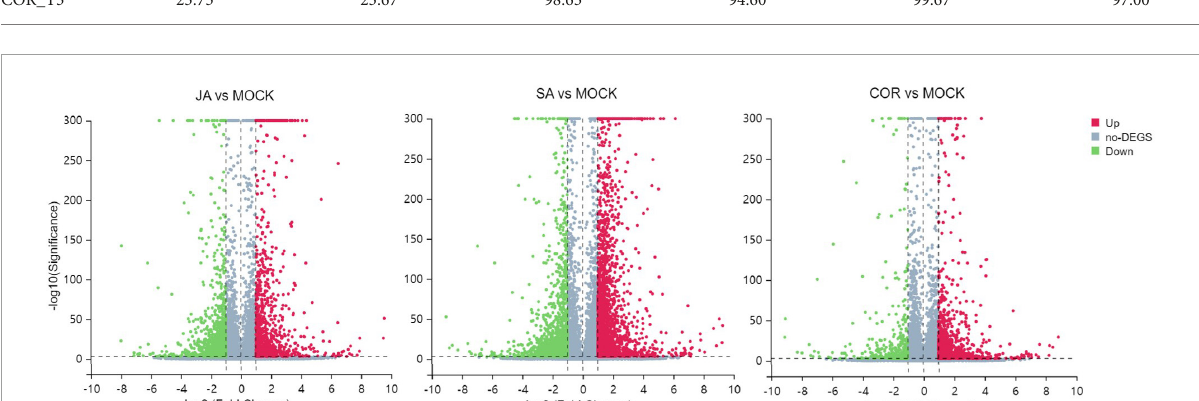
FIGURE3 Volcano plots for differentially expressed genes (DEGs) including jasmonate acid (JA) treatment vs. mock treatment, salicylic acid (SA) treatment vs. mock treatment and coronatine (COR) treatment vs. mock treatment. The log 2 fold change ( X -axis) is plotted against the log 10 FDR ( Y -axis). Red dots and green dots represent DEGs that were either up-regulated or down-regulated. Gray dots denote genes that were not significantly different between treatments and mock.